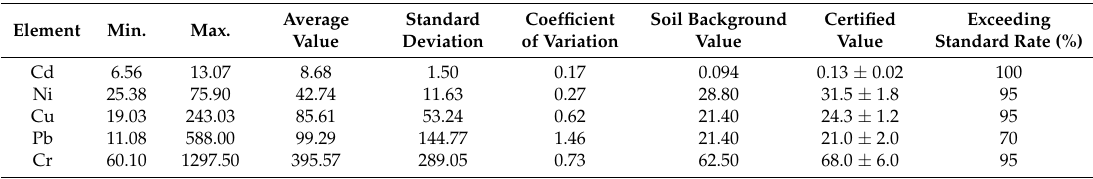
Table 3. Basic statistical parameters of the mass ratio of heavy metals in dust of leisure squares in Yanta District in Xi’an